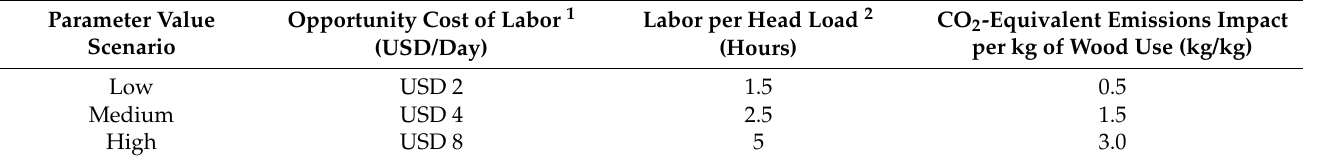
1 Corresponds to: USD 1/day, USD 2/day and USD 4/day per capita incomes which are the 20th percentile, median, and 80th percentile Atlas (i.e., foreign exchange value) population-weighted median incomes in SSA respectively. 2 Estimates are roughly consistent with household time use surveys